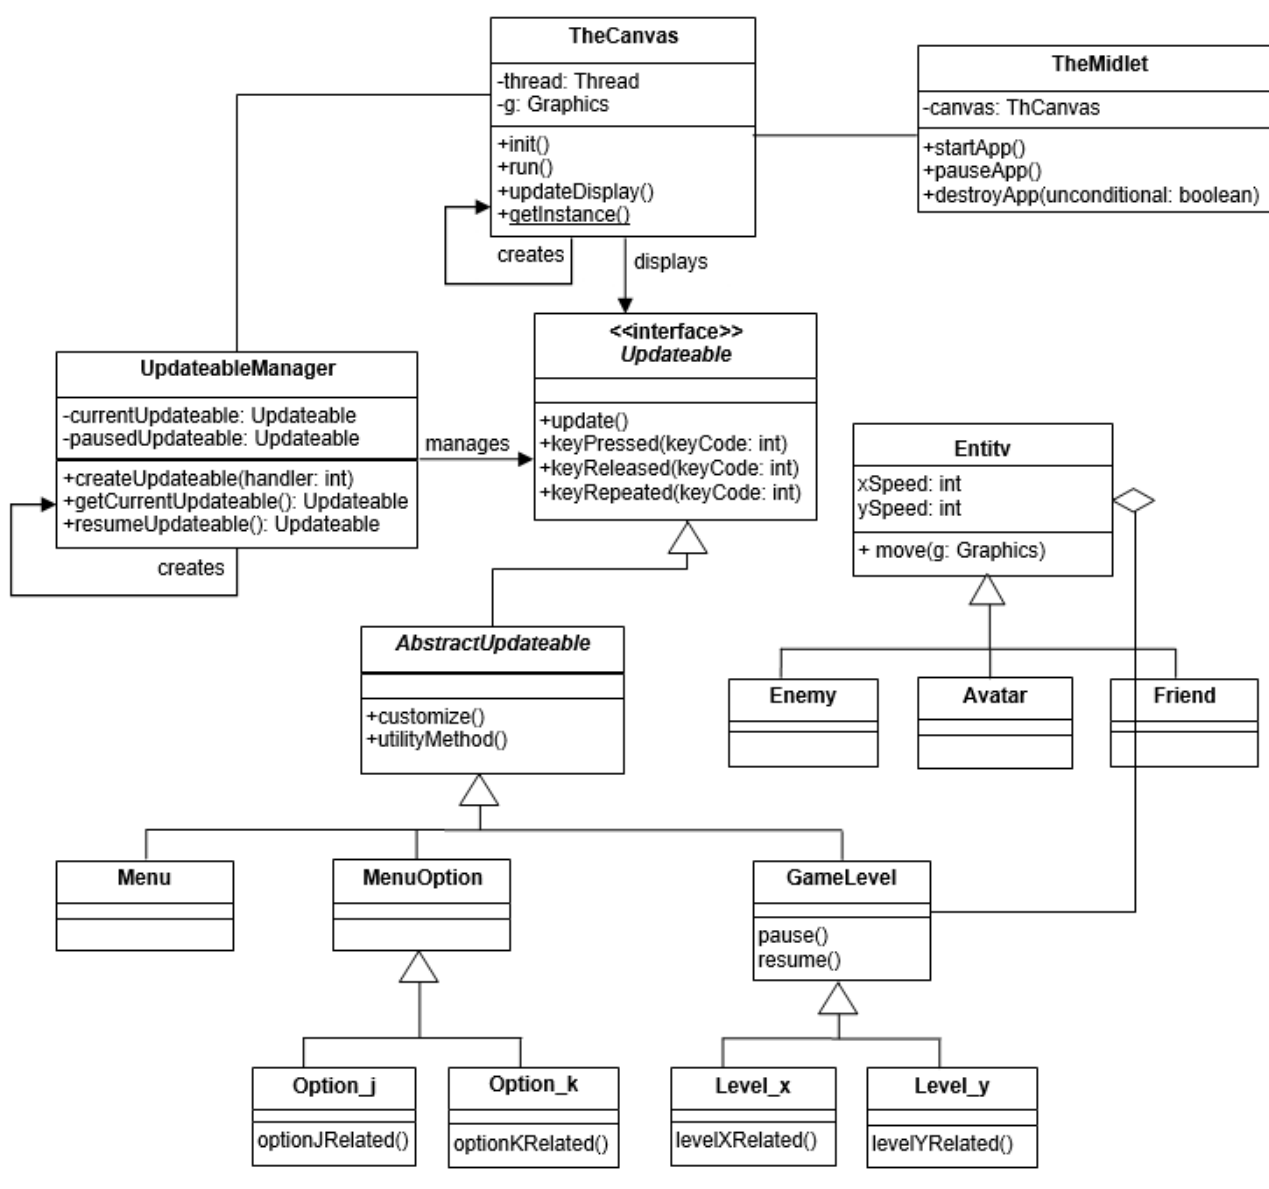
Figure 18. Integration of an individual pattern into a complete game.